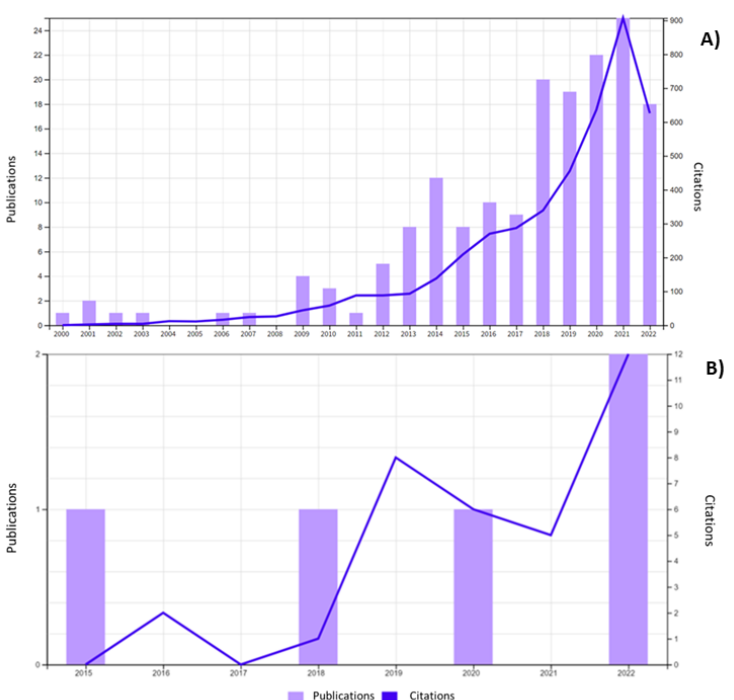
Figure 3. Outcomes of a Web of Sciences search from 1 January 2000 to September 2022, ac- cessed on 4 October 2022; ( A ) By the term “Tobramycin nanoparticles”; ( B ) By the term “To- bramycin